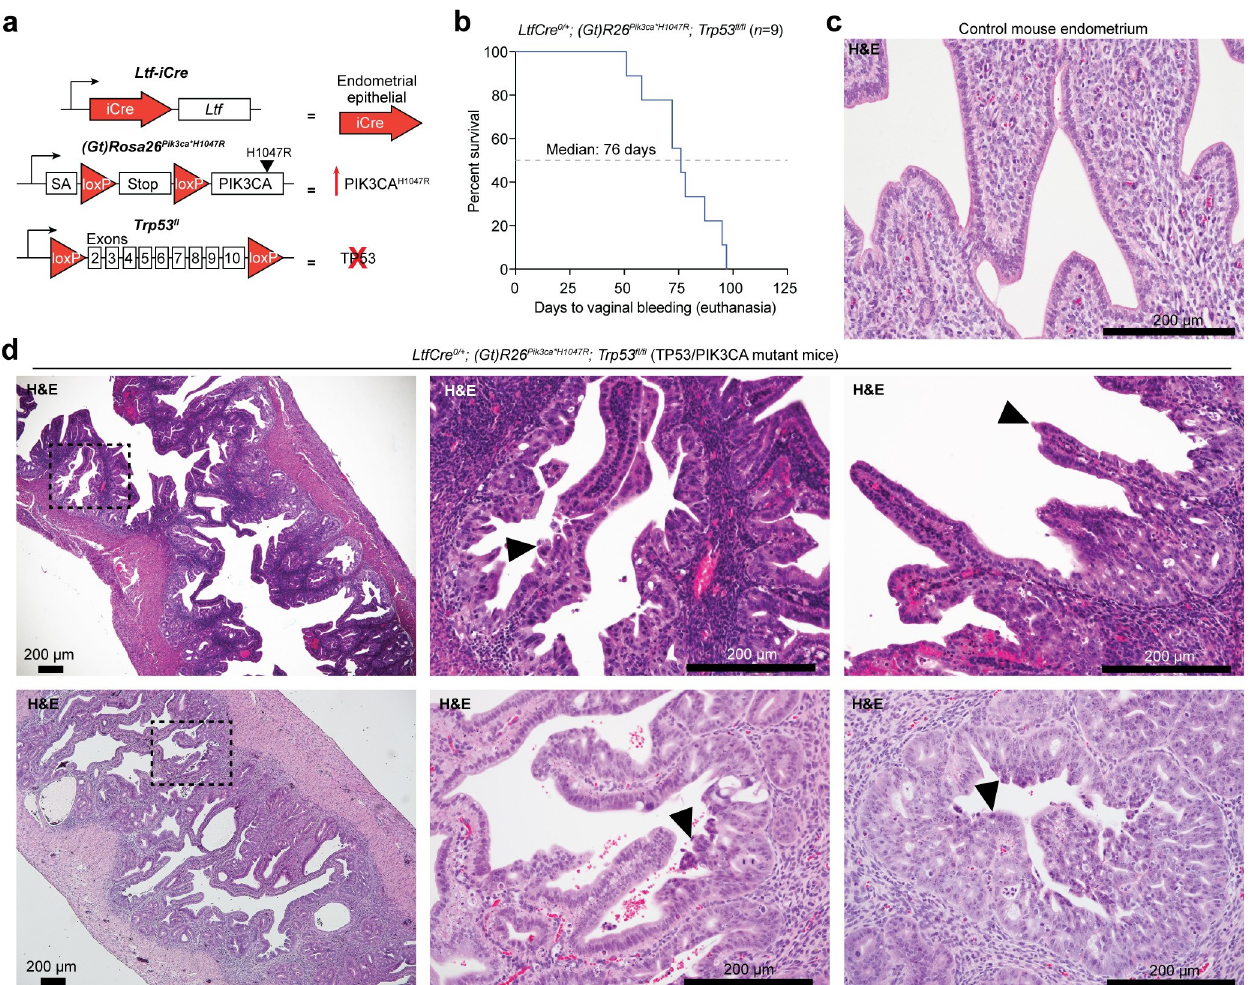
Fig 2. TP53 loss with oncogenic PIK3CA activation results in endometrial intraepithelial carcinoma. a , Diagram of mouse alleles used in this study. b , Survival data of LtfCre 0/+ ; (Gt)R26 Pik3ca � H1047R ; Trp53 fl/fl (TP53/PIK3CA mutant) mice. Survival is measured as days to vaginal bleeding, requiring euthanasia. c , Representative H&E histology of control mouse endometrium from CRE-negative littermates. d , Representative H&E histology of endometrial intraepithelial carcinomas and hyperplastic epithelia in TP53/PIK3CA mutant uterus. Arrowheads denote dyplastic endometrial epithelia.